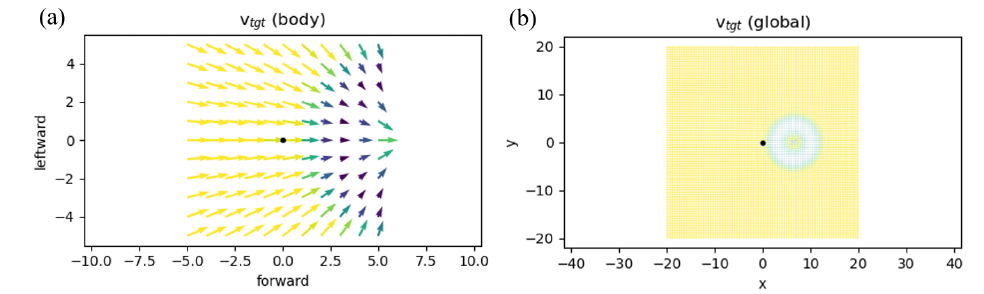
Figure 4. The body target velocity guiding the musculoskeletal body toward the coordinates (5,0) is shown in ( a ). The global environment in which the musculoskeletal should reach the coordination of (5,0) is illustrated in ( b ).